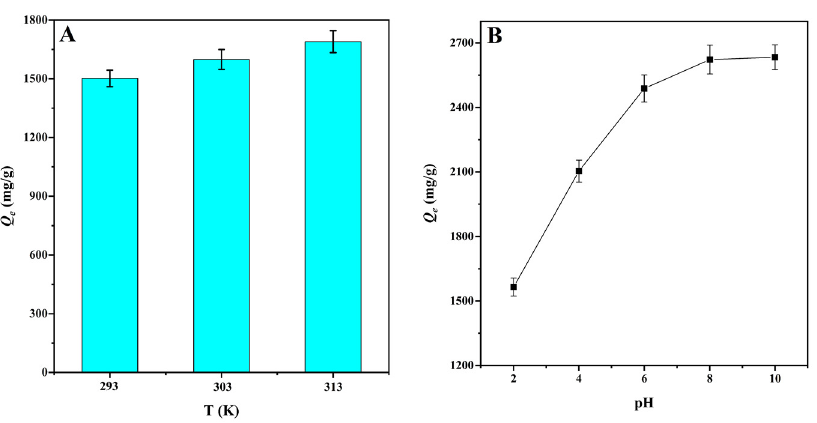
Figure 6. ( A ) The effect of temperature on the adsorption capacities for MG at natural pH value ( V : 100 mL; C 0 : 400 mg/L; natural pH: 3.8 ± 0.2) and ( B ) the effect of pH on the adsorption capacities of MG at 303 K ( V : 100 mL; C 0 : 400 mg/L). Table 4. Thermodynamic parameters for the adsorption of MG onto CMBC-4-700-30. Temperature (K)